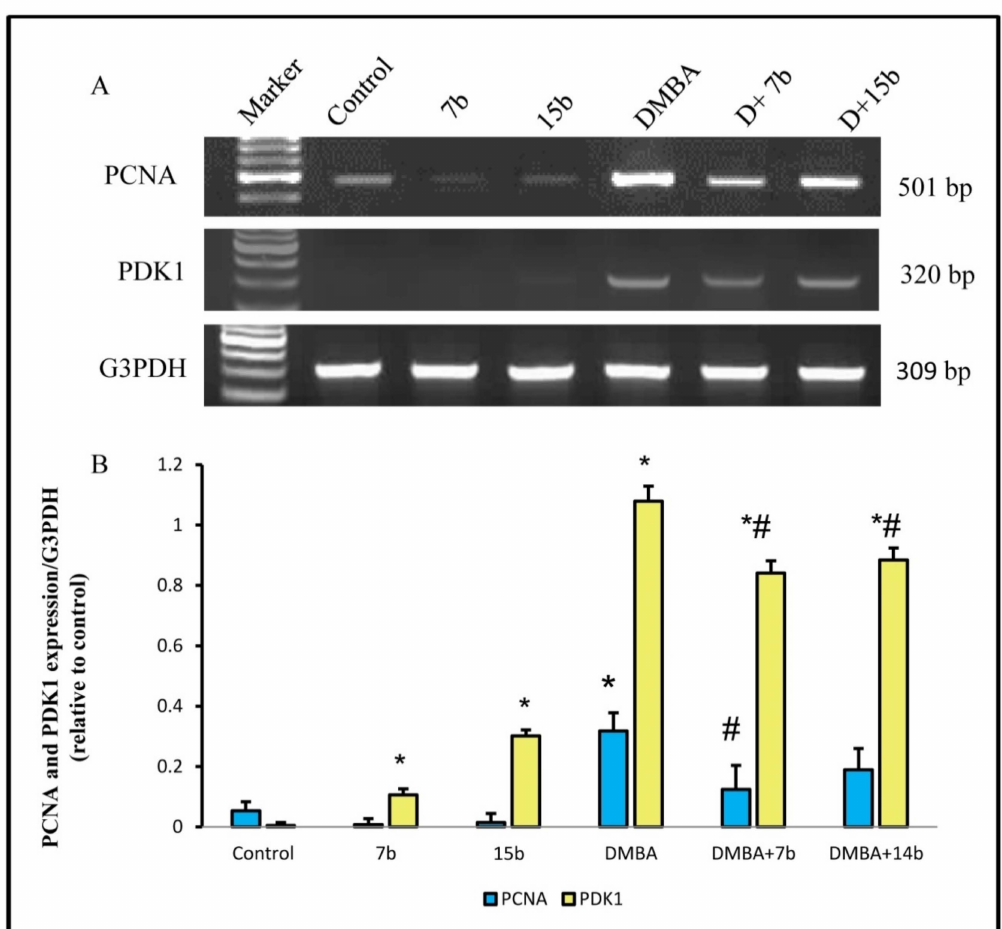
Figure 2. Effect of 7b and 15b compounds on changes in gene expression induced by DMBA in breast. Values are means ± SE of 10 rats. * p < 0.05 vs. control group; # p < 0.05 vs. DMBA group. ( A ) Upper panels are mRNA expression of examined gene. ( B ) Lower columns are densitometric analysis of gene